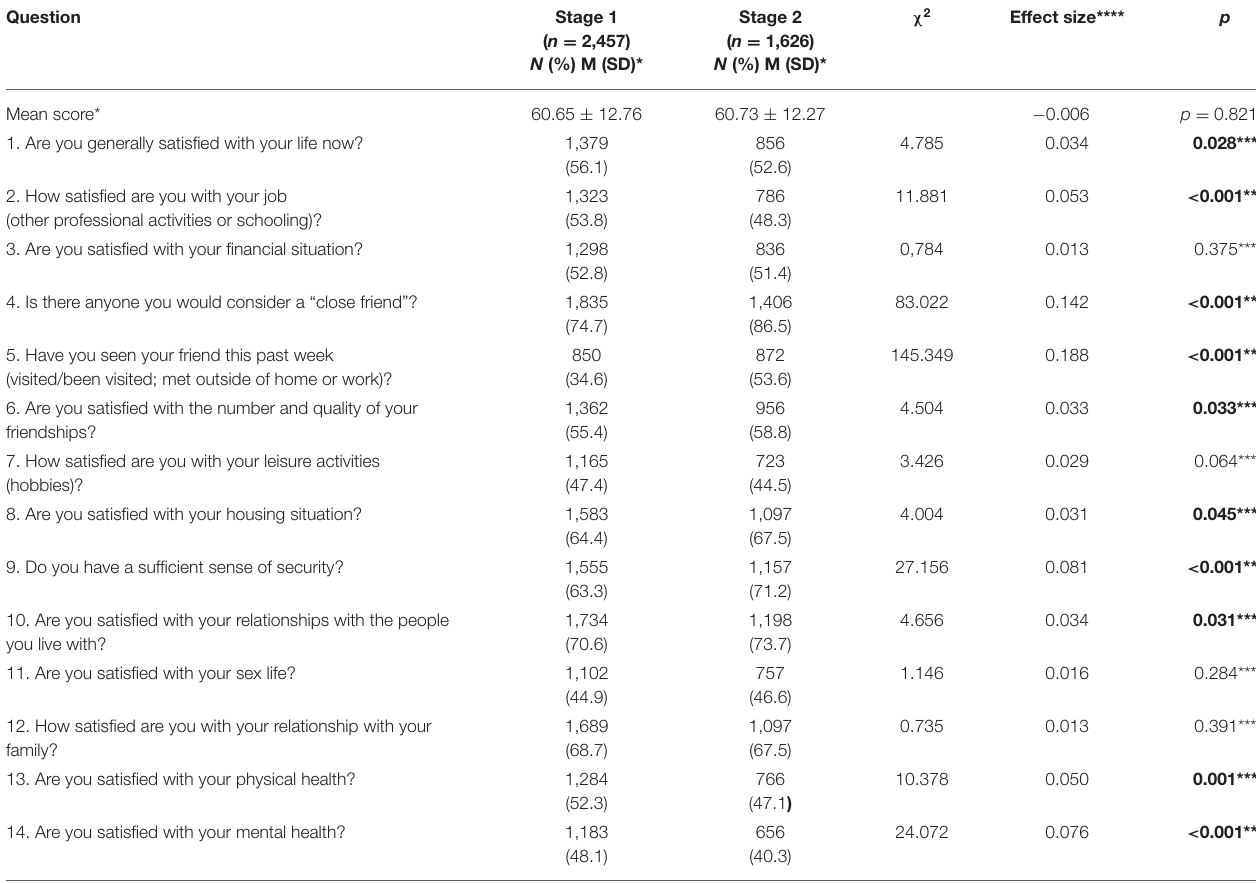
TABLE 4 | The level of satisfaction (including 3 of 7 answers which are positive: could not be better/I am satisfied/I am somewhat satisfied) for the individual questions of the MANSA scale by survey stage.